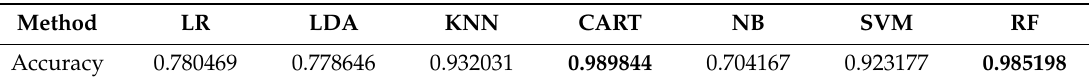
Table 3. RF Accuracy Results Comparison to Some Other Classifiers For Hydraulic Test Rig Fault